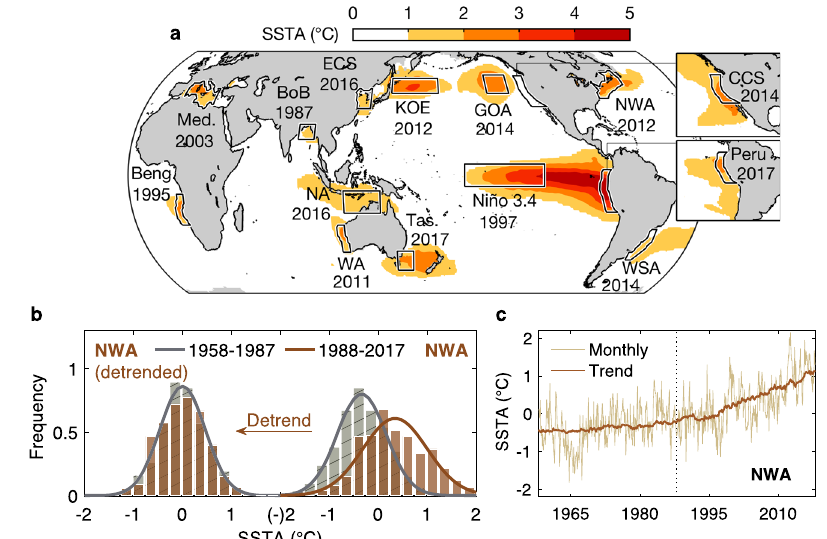
Fig. 1 | Historical Marine Heatwave (MHW) events and example of nonlinear trend in fl uencing Probability Distribution Function (PDF). a Sea Surface Tem- perature Anomaly (SSTA) of historical MHW events during their peak months, following previous studies 3 – 5 and references therein. Outlines mark regions of interest for this study, and the year in which the historical event occurred is also indicated. Peak months of these events are listed in Supplementary. Beng. Ben- guela, BoB Bay of Bengal 50 , CCS California Current System, ECS East China Sea 51,52 , GOA Gulf of Alaska, KOE Kuroshio-Oyashio Extension 53,54 , Med. Mediterranean,